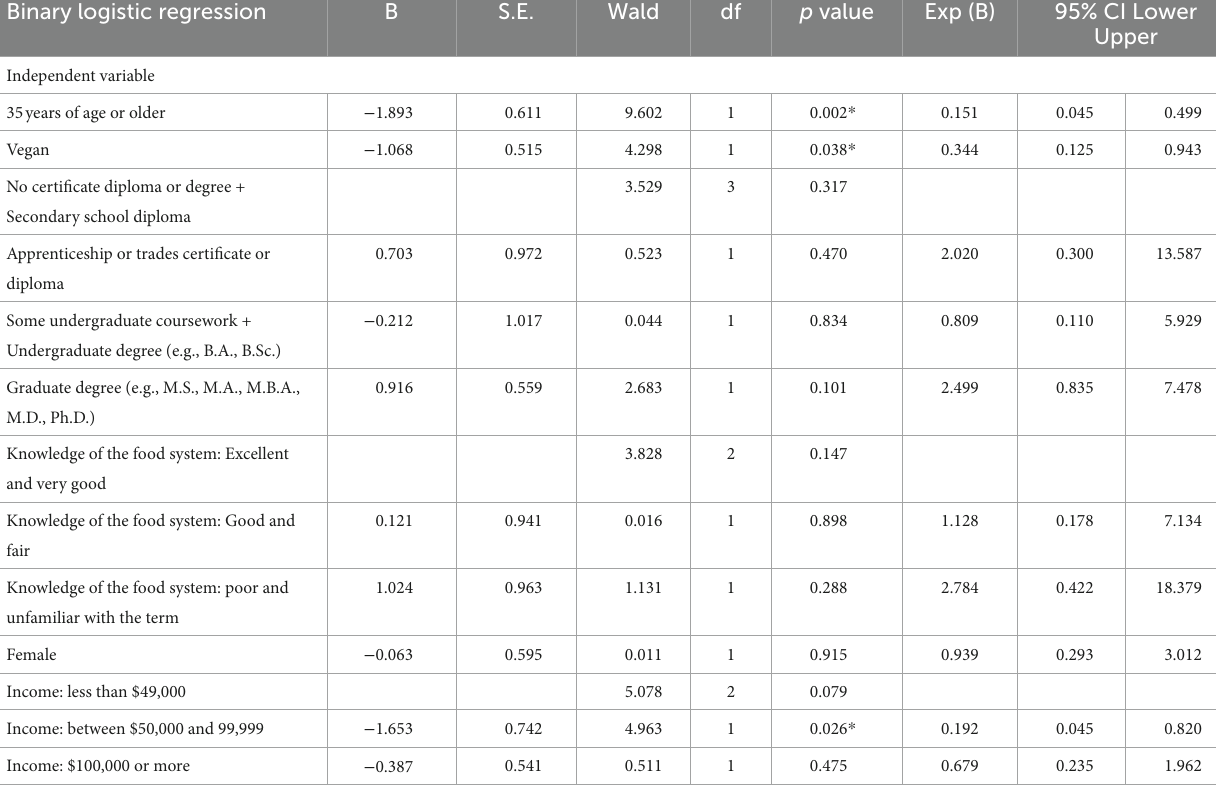
TABLE 4 Binary logistic regression for positive feelings towards yeast-derived agriculture. Binary logistic